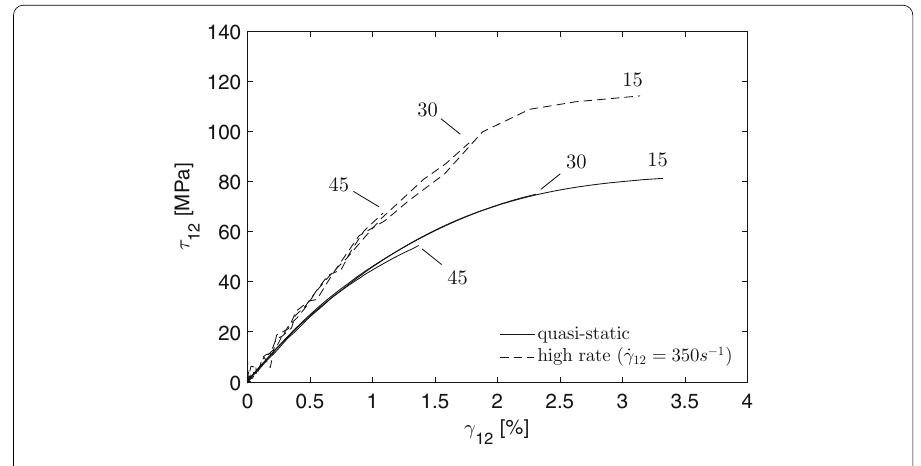
Fig. 4 In-plane shear behavior derived from off-axis tension tests (engineering stress–strain curves shown)